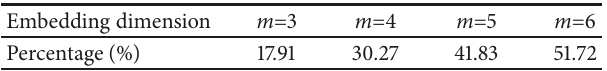
Table1:Percentageofequalvaluesfoundinembeddingvectorswith diverse embedding